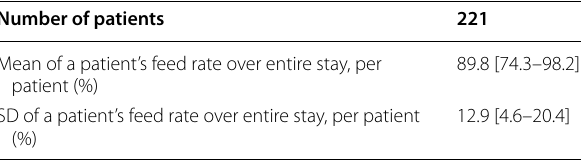
Data presented as median [IQR] where appropriate